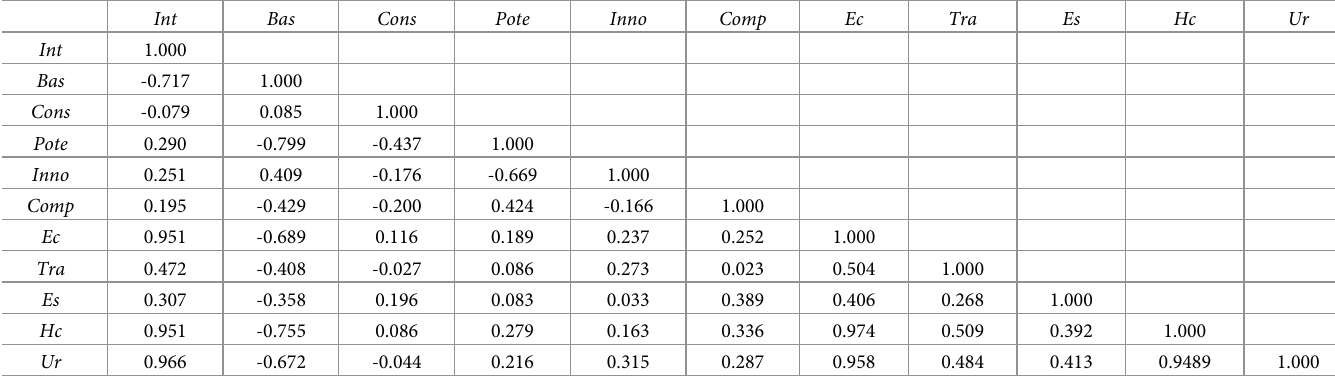
Table 5. Correlation between